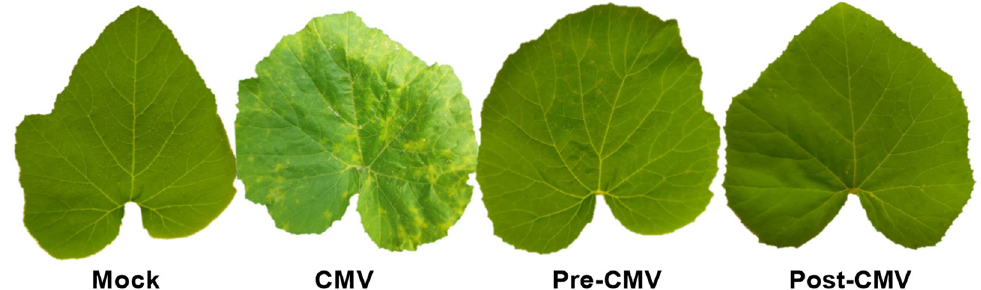
Figure 5. A photograph of disease symptoms on squash leaves infected with CMV 18 dpi. Mock: plants inoculated with viral inoculation buffer; CMV: plants mechanically inoculated with CMV; Pre-CMV: plants treated with Ag-NPs, 24 h before CMV inoculation; Post-CMV: plants treated with Ag-NPs, 24 h after CMV inoculation.